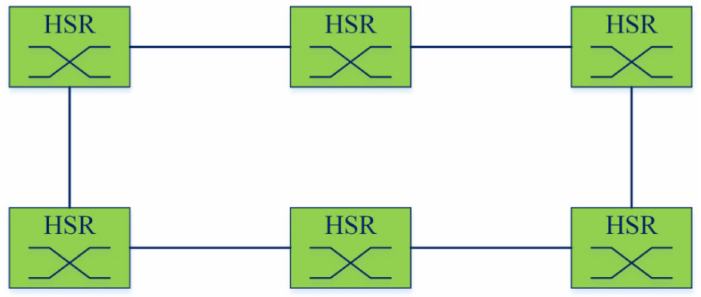
Figure 7. SwitchBox-based HSR in ring topology.